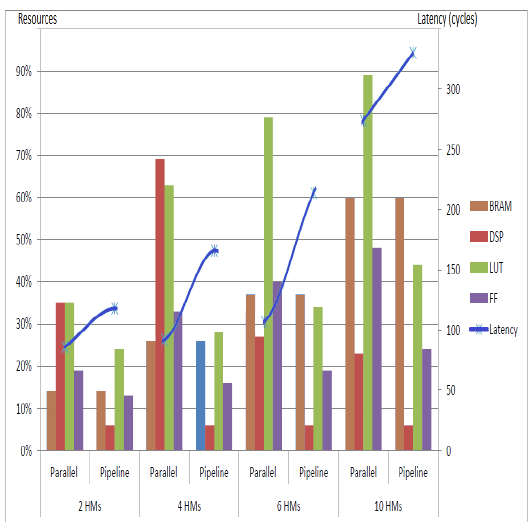
Figure 22. Results of the HW implementation for the scalable BN monitors in terms of FPGA resources (BRAM, DSP, LUT, FF) and in terms of performance with pipeline and parallel